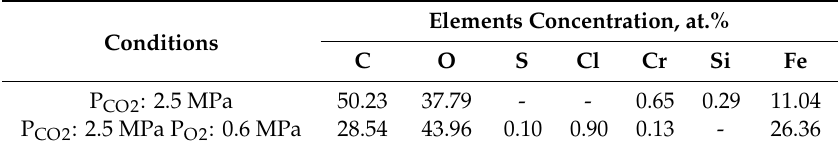
Table 3. Quantitative EDS results of erosion-corrosion products of the tested material under di ff erent conditions. Elements Concentration, at.% Conditions C O S Cl Cr Si Fe P CO2 : 2.5 MPa 50.23 37.79 - - 0.65 0.29 11.04 P CO2 : 2.5 MPa P O2 : 0.6 MPa 28.54 43.96 0.10